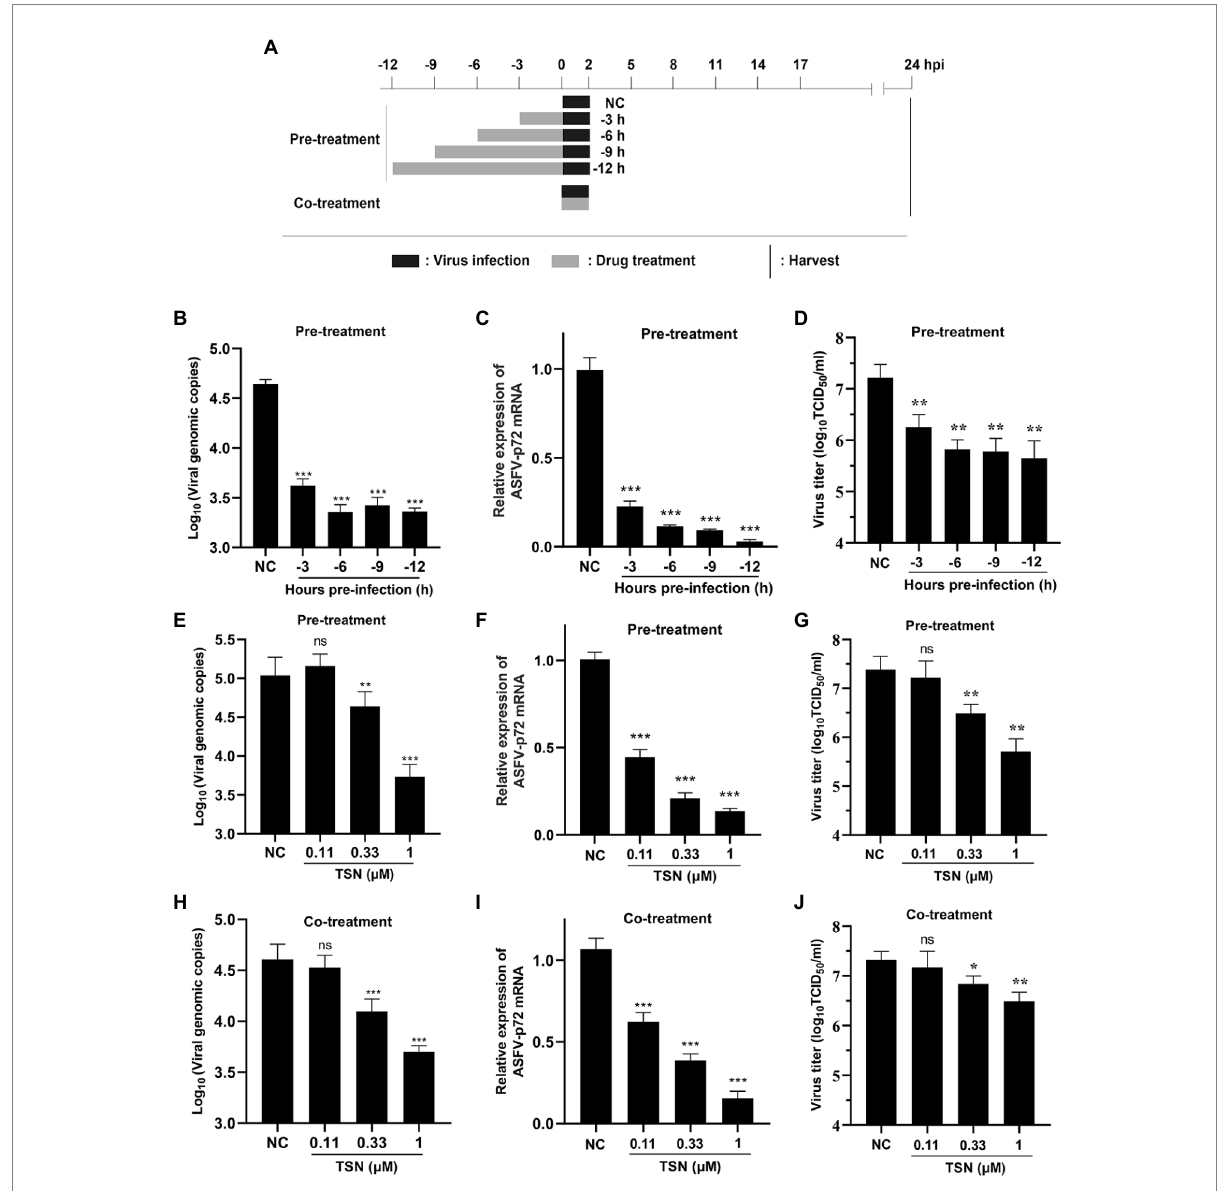
FIGURE 4 TSN suppresses ASFV replication in pre-and co-treatment modes in PAMs. (A) PAMs were seeded in 48-well plates for 3 h and then treated with TSN (1 μ M) for 3–12 h prior to ASFV infection (pre-treatment), for 2 h during viral infection (co-treatment). For all two treatment modes, 0.014 MOI of ASFV GZ201801-38 was used to infect the PAMs for 2 h. After 24 hpi, the cells were subjected to qPCR or RT-qPCR. (B–D) For the pre-treatment experiment, the DNA level of ASFV p72 gene was determined by qPCR (B) , the mRNA level of ASFV p72 was determined by RT-qPCR (C) and the virus titer of ASFV was determined by endpoint dilution method (D) . (E–G) For the pre-treatment experiment, the DNA level of ASFV p72 gene was determined by qPCR (E) , the mRNA level of ASFV p72 was determined by RT-qPCR (F) and the virus titer of ASFV was determined by endpoint dilution method (G) . (H–J) For the co-treatment experiment, the DNA level of ASFV p72 gene was determined by qPCR (H) , the mRNA level of ASFV p72 was determined by RT-qPCR (I) and the virus titer of ASFV was determined by endpoint dilution method (J) . *** denotes p < 0.001; ** denotes p < 0.01; ns denotes no significant difference. NC denotes the negative